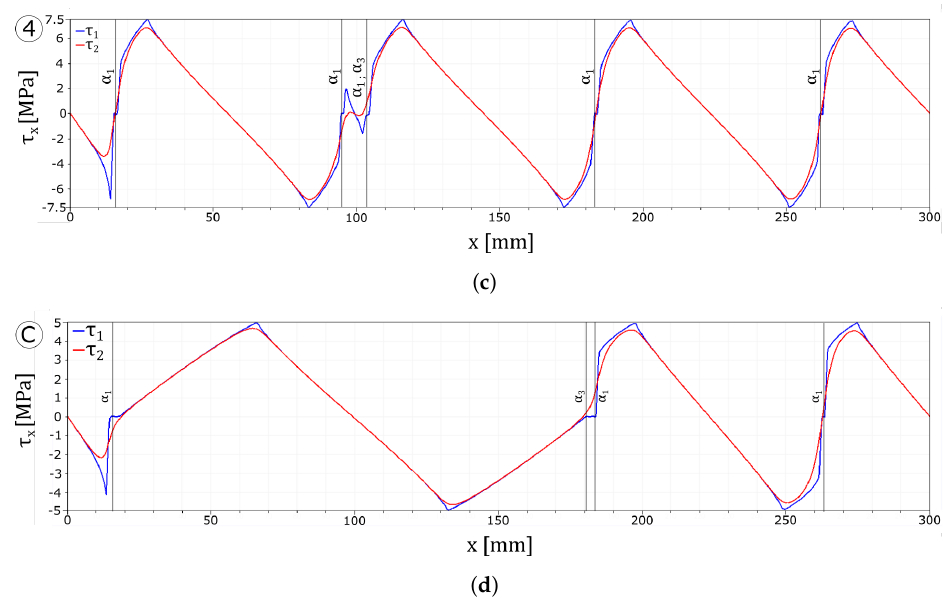
Figure 13. Numerical results: stress plots. ( a ) UD tau7.5 glass plies stress profiles. ( b ) UD d6 glass plies stress profiles. ( c ) UD tau7.5 interface stress profiles. ( d ) UD d6 interface stress profiles.